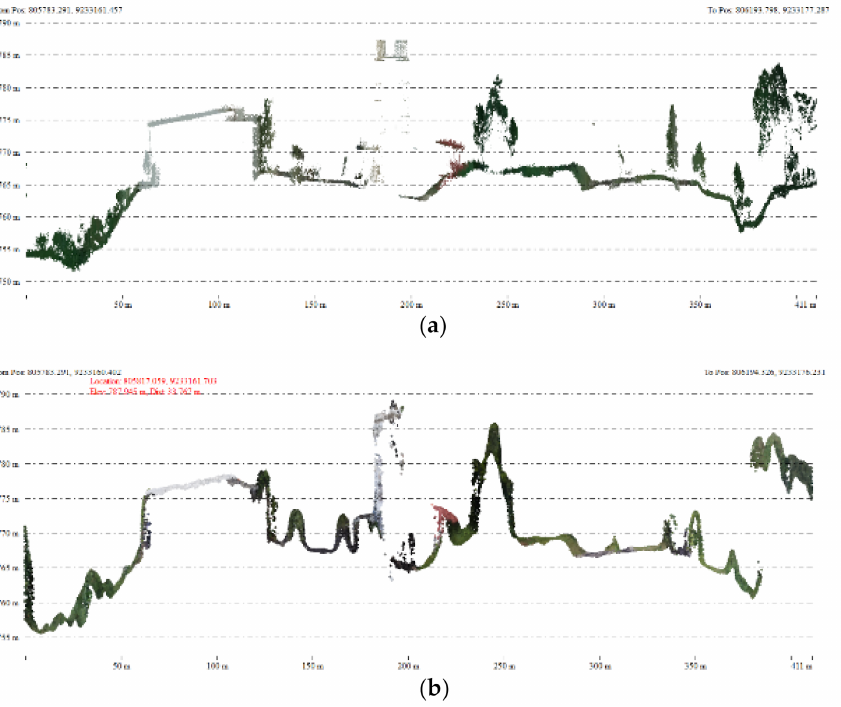
Figure 3. The cross-section of the point clouds resulting from ( a ) LiDAR data acquisition and ( b ) photogrammetry data